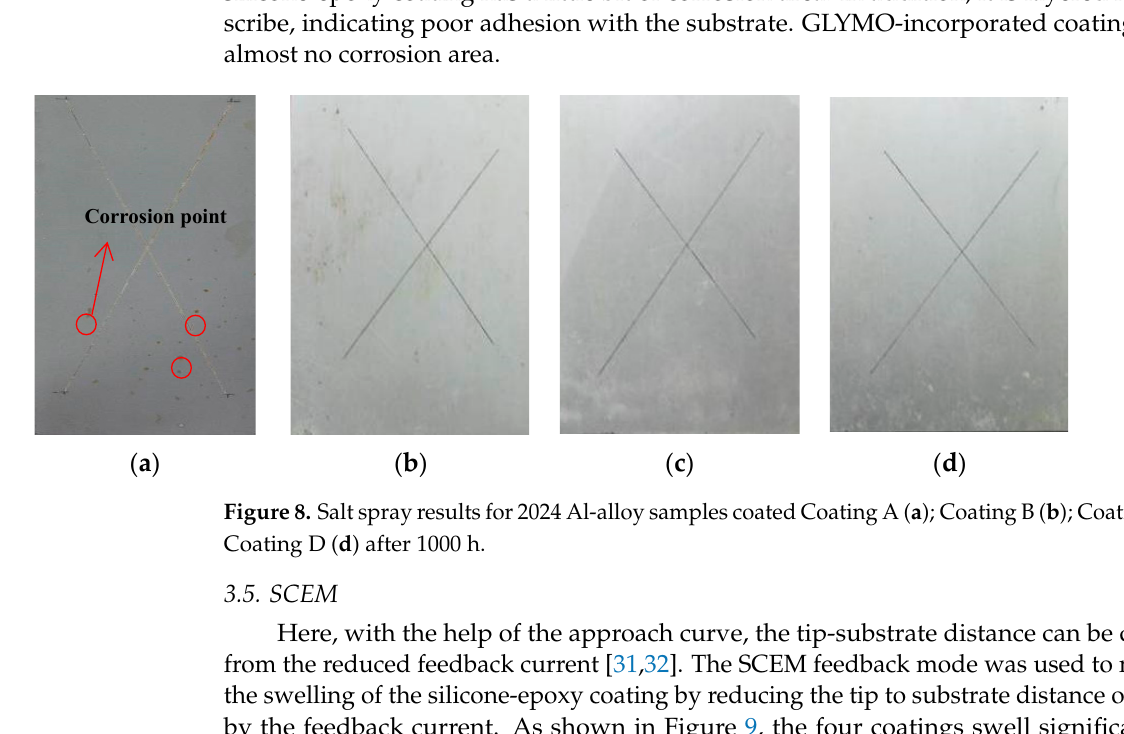
Table 4. The effects of GLYMO on adhesion strength of the silicone-epoxy coatings.